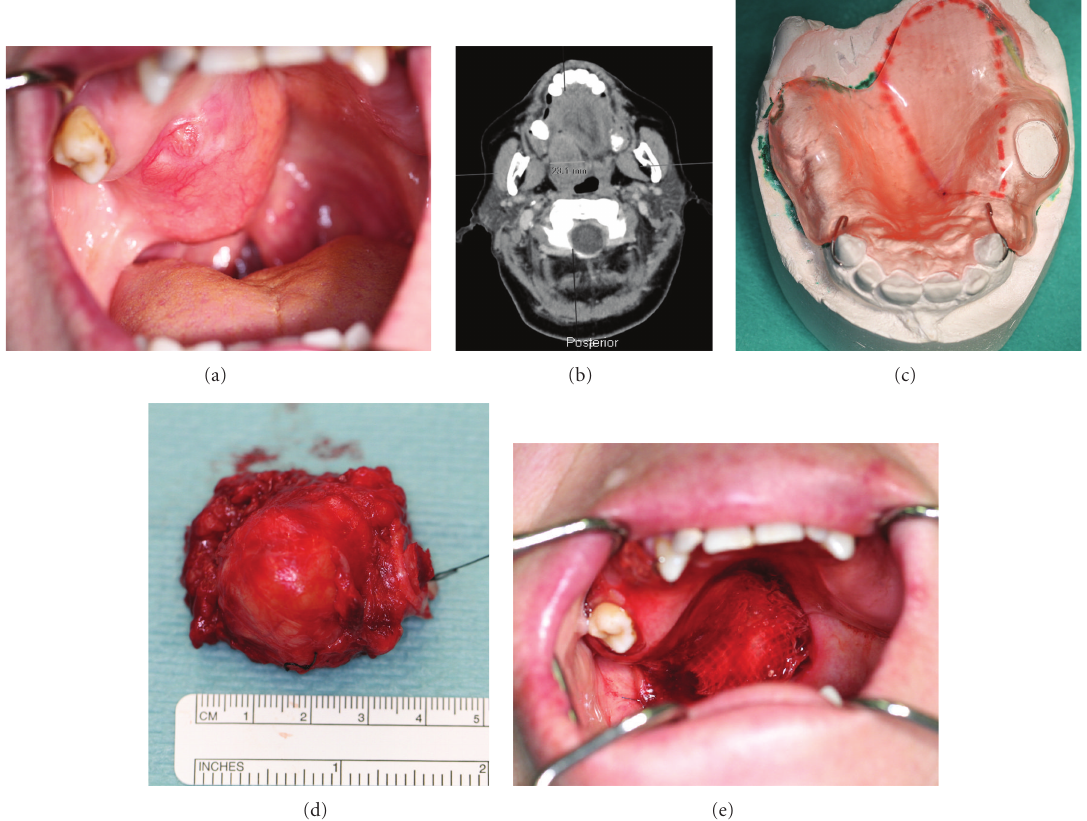
Figure 4: (a) Pleomorphic adenoma of the junction between the soft and hard palates in a 60-years-old female patient. (b) CT horizontal scan of the patient. (c) Prosthetic obturator. (d) Surgical specimen of resected pleomorphic adenoma. (e) Postoperative